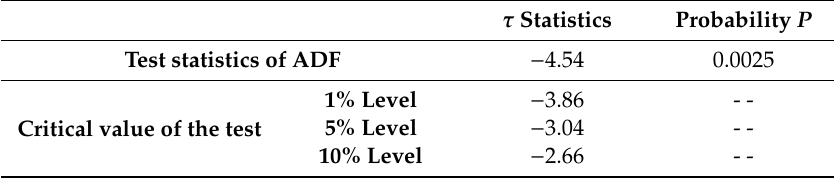
Figure 5. Autocorrelation coefficient and partial autocorrelation coefficient of the pit gain time series after the second-order difference. Table 3. Unit root test results of the pit gain time series after the second-order difference.